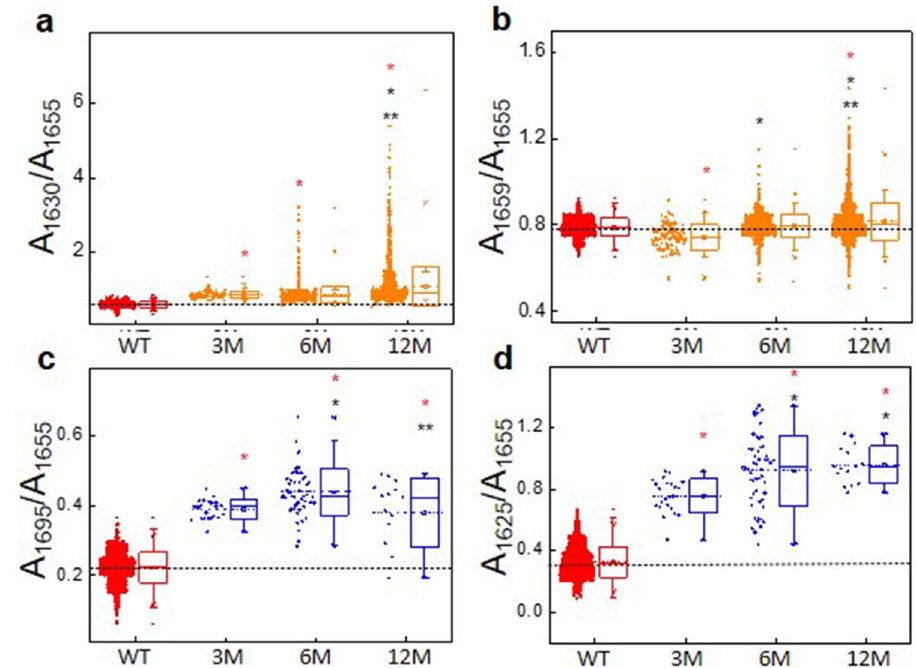
Figure 3. Box plot graphics depicting the absorbance ratio values corresponding to the two different types of aggregated species identified at 3, 6, and 12 months in APP/PS1 and WT mice. Amyloid fibrils ( a , b : the ratios A 1630 /A 1655 and A 1659 /A 1655 are the two spectral features of fibrillary structures as explained in “Results and discussion” section) and Oligomeric/granular aggregates ( c , d : the ratios A 1695 /A 1655 and A 1625 /A 1655 are the two spectral features of non-fibrillary aggregated structures as explained in “Results and discussion” section). Ratios are calculated from the second derivative spectra of the outliers in each segment ( a – f ) in the PCA shown in Fig. 1. Boxplot shows the median (center line), interquartile range (IQR) (box); whiskers represent the most extreme data located no more than 1.5xIQR from the edge of the box, and outliers are the points outside this range. T-test is used for comparison with WT (red*), 12 month mice (*), and between 3 and 6 month mice (**) at p < 0.002. Origin 9.1 and Microsoft power point 2016 software were used for graphical